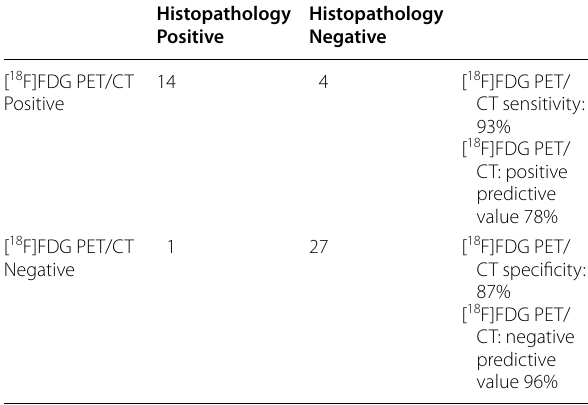
Table 1 Results from histopathology and [ 18 F]FDG PET/CT including sensitivity, specificity, positive and negative predictive values of [ 18 F]FDG